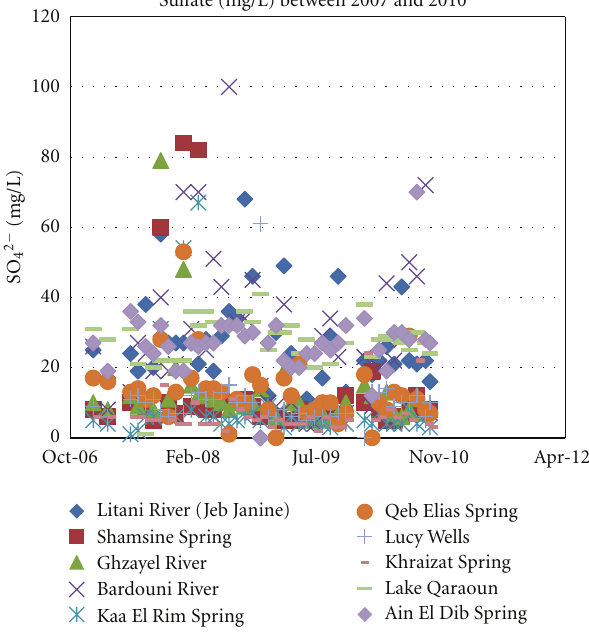
Figure 12: Sulphate concentrations for years 2007 through